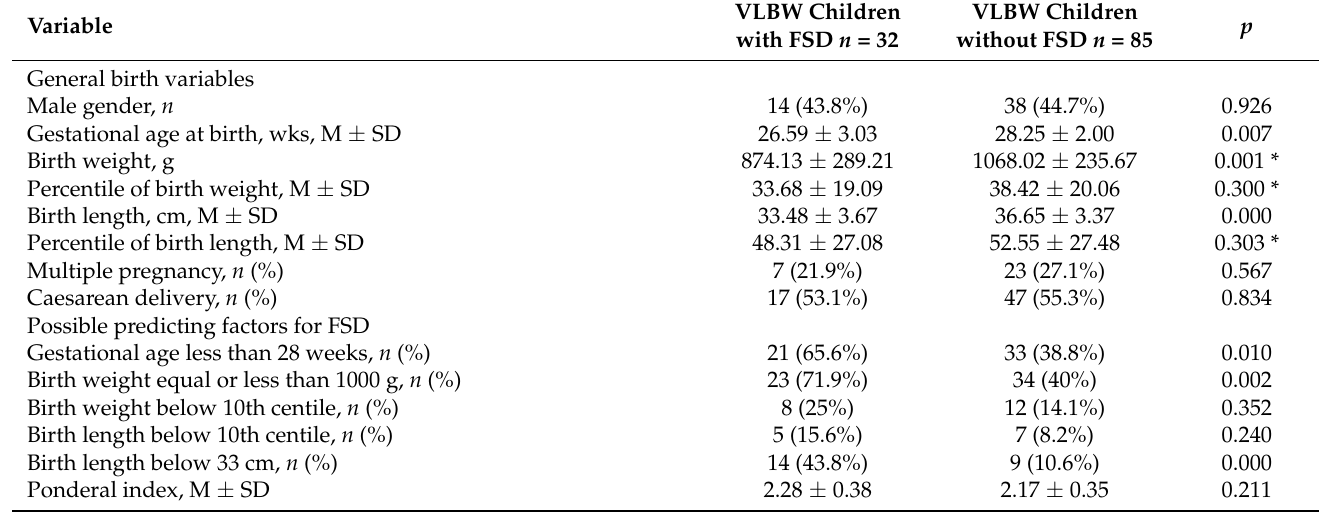
Table 2. Comparison of preterm children by feeding and swallowing disorders (FSD) after discharge from the maternity hospital regarding significant possible risk factors for FSD ( n =